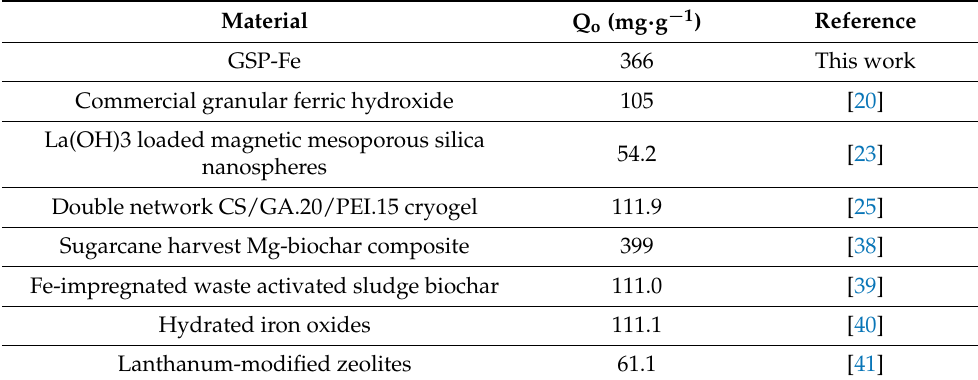
Table 5. Phosphorus sorption values obtained in this work and reported in